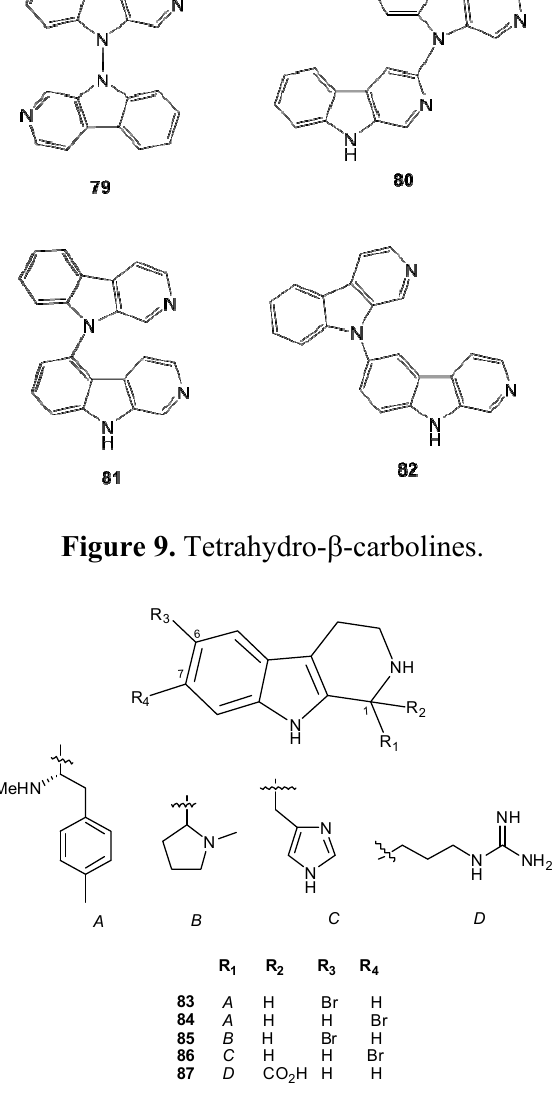
Figure 10. 7-Membered additional ring containing tetrahydro 